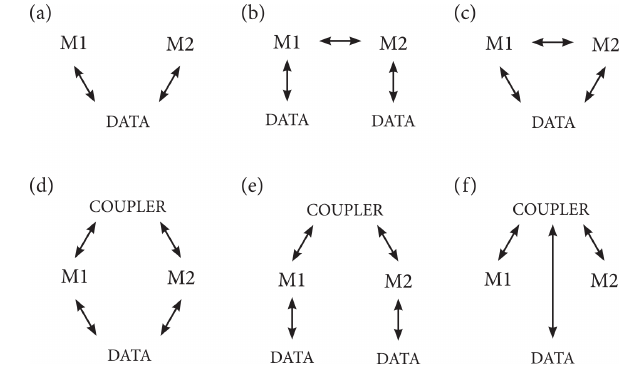
Figure 1. Approaches to model coupling. (a) Loose model in- tegration via file/data exchange between model 1 (M1) and model 2 (M2); (b) models may manipulate parameters, variable val- ues, or the scheduling of processes in another model but they inter- act with independent data (i.e. model inputs and outputs); (c) the behaviour of models is the same as (b) except that they also affect each other by interacting with the same data (i.e. the output of one model may be used as the input for another); (d) a coupler coor- dinates run time and scheduling and may pass some information between models, models may also interact through manipulating data (model input and output files); (e) a coupler coordinates the run time and scheduling of the individual models and passes infor- mation between models that primarily use their own data; (f) the coupler coordinates all interactions between models and data.